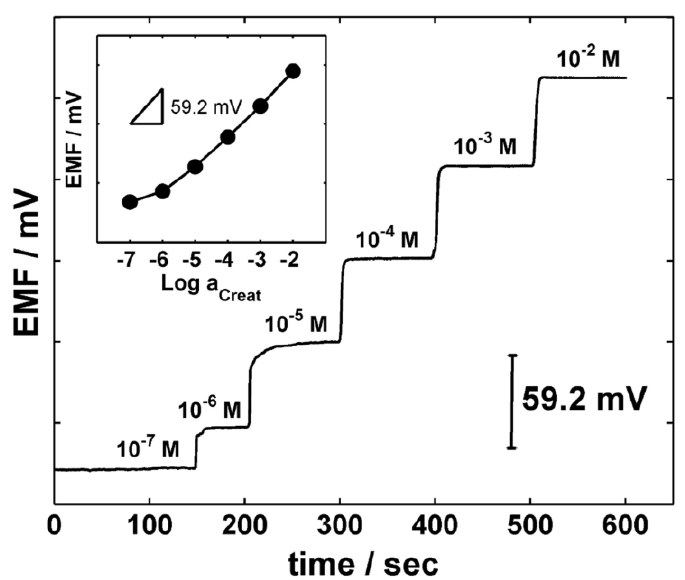
Figure 7. Potential-time plot for different creatinine concentrations of the calix [4] pyrrole-based sensor. Inset is reported the calibration curve (RSD 0.6% for N = 5). Reprinted from [46].